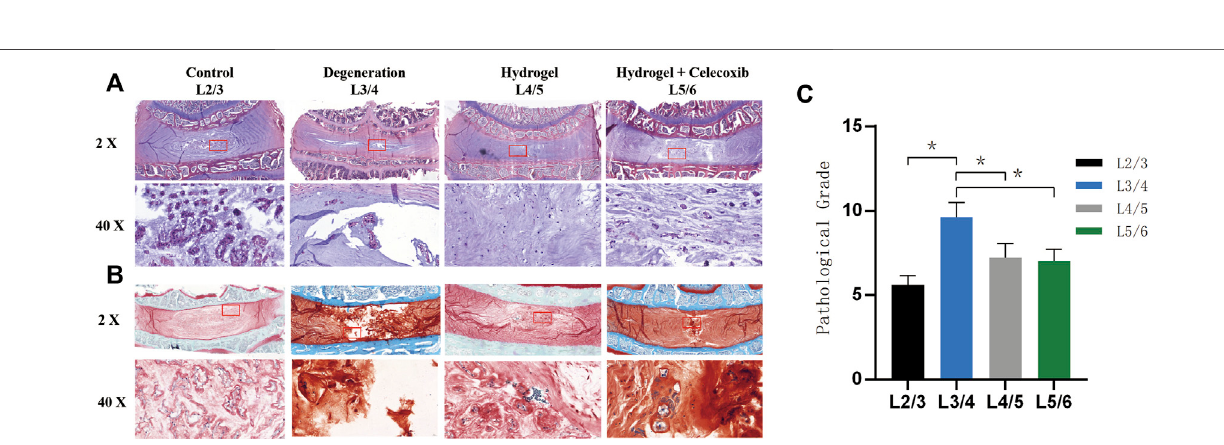
Frontiers in Bioengineering and Biotechnology |